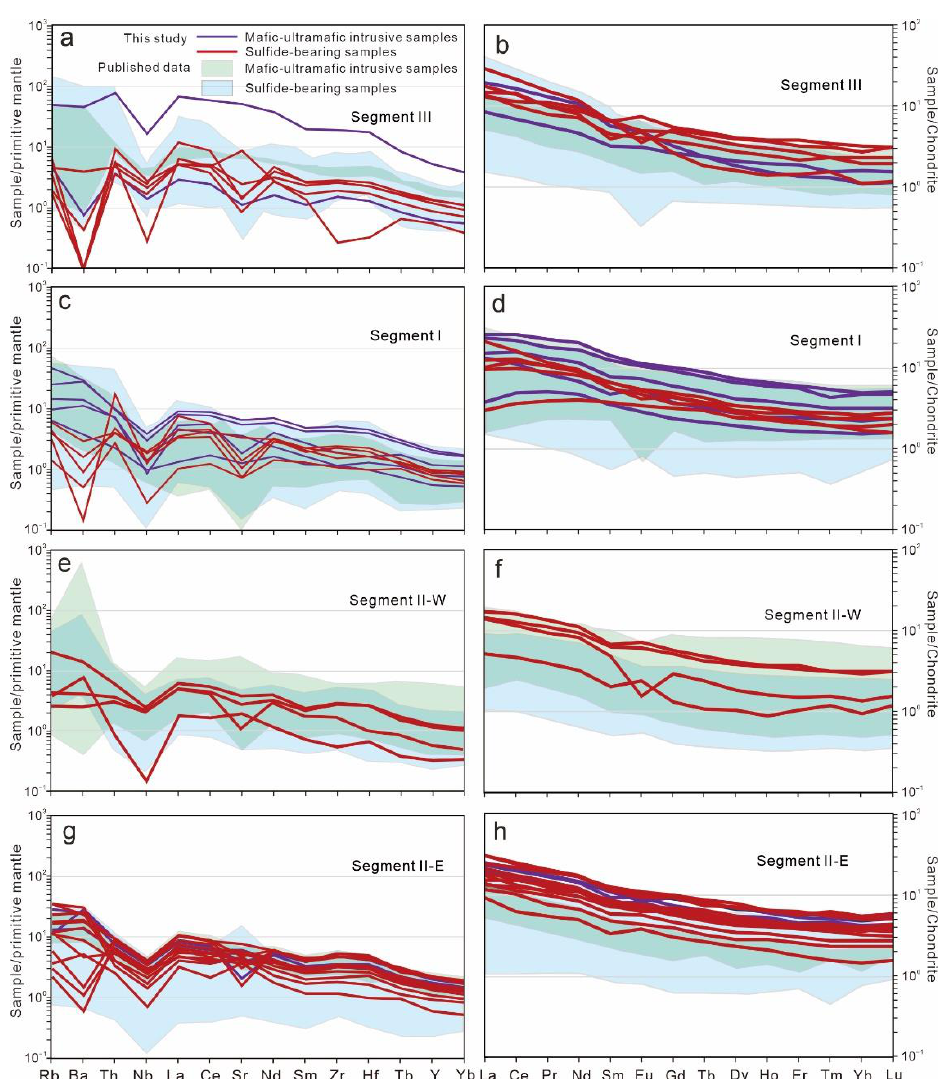
Figure 5. Primitive mantle-normalized trace element spider diagrams and chondrite-normalized rare-earth element (REE) patterns of the mafic–ultramafic intrusions and sulfide-bearing samples from ( a , b ) Segments III, ( c , d ) I, ( e , f ) II-W, and ( g , h ) II-E at the Jinchuan deposit. Data are from this study and [29,36,44,46,65]. The primitive mantle and chondrite standard values are from [68].